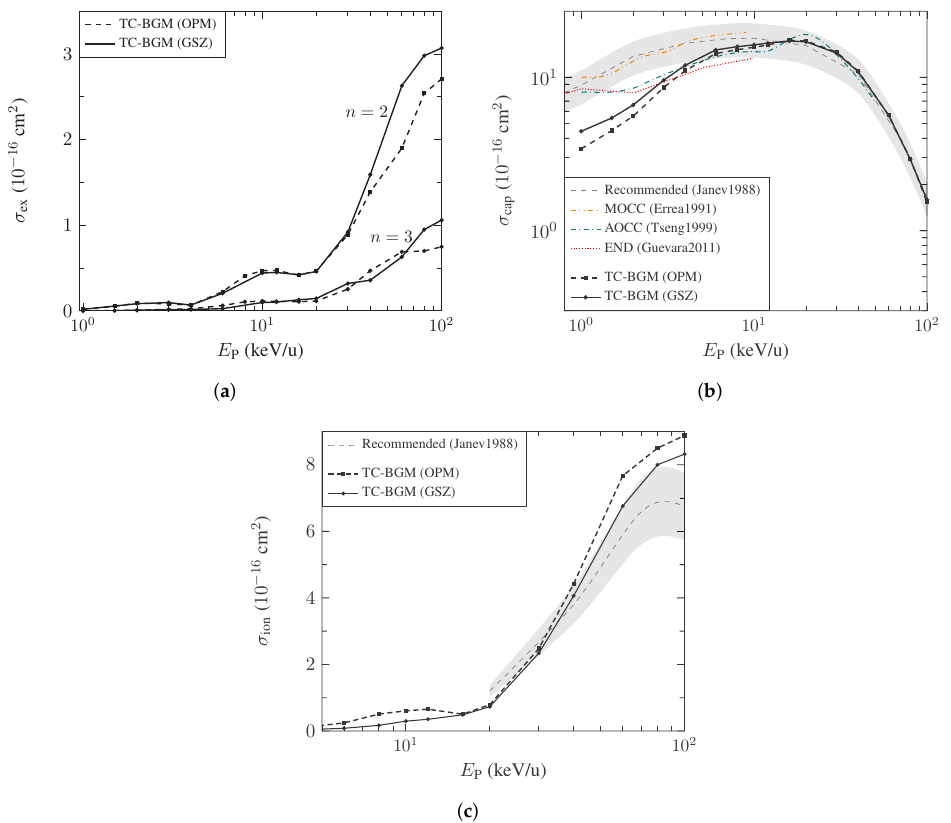
Figure 2. Cross sections for C 3 + -H(1s) collisions from 1 to 100 keV/u: ( a ) target excitation; ( b ) electron capture; ( c ) ionization. Recommended data from Ref. [8]. Theory: present TC-BGM, MOCC [9], AOCC [25], and END